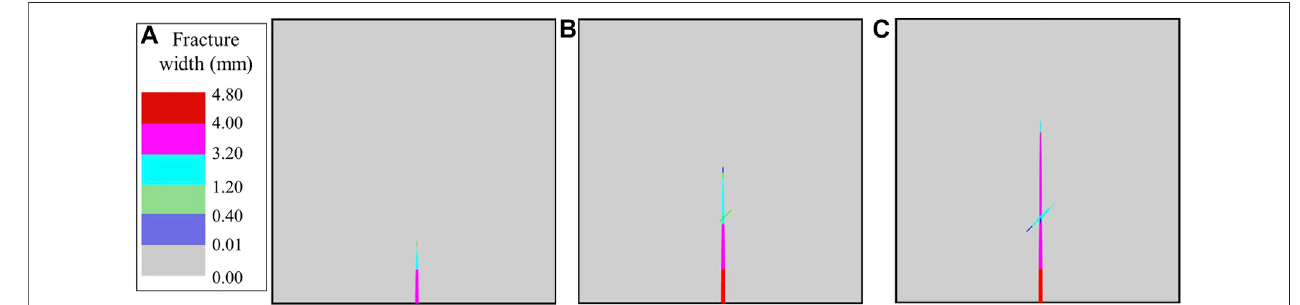
Frontiers in Earth Science |